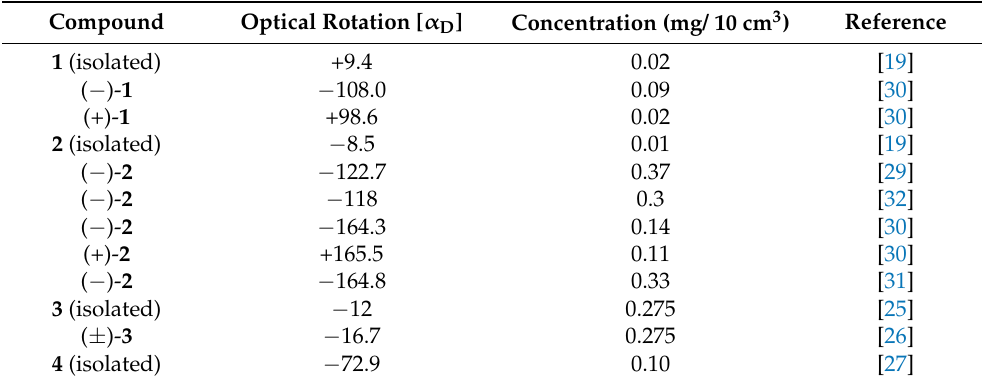
Table 1. Reported optical rotation for the isolated and synthetically prepared natural